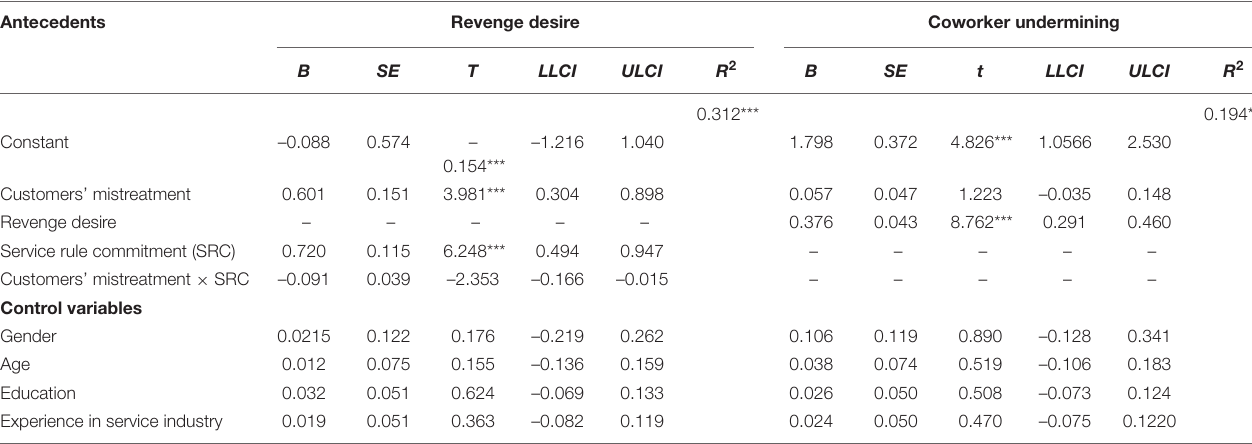
TABLE 3 | Results of the moderated-mediation model